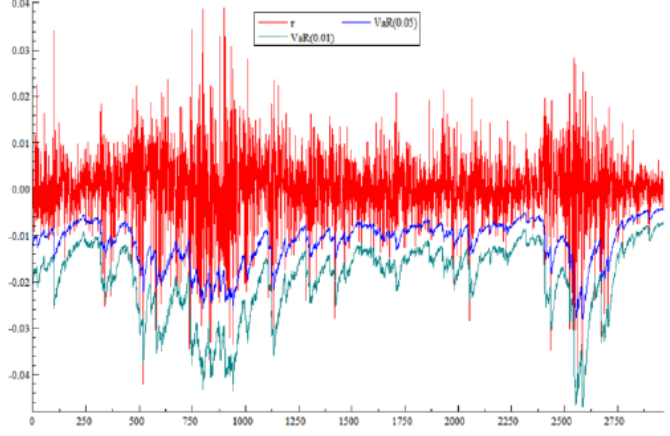
Fig. 5 Risk Values Under the Number of Quantiles 0.01 and